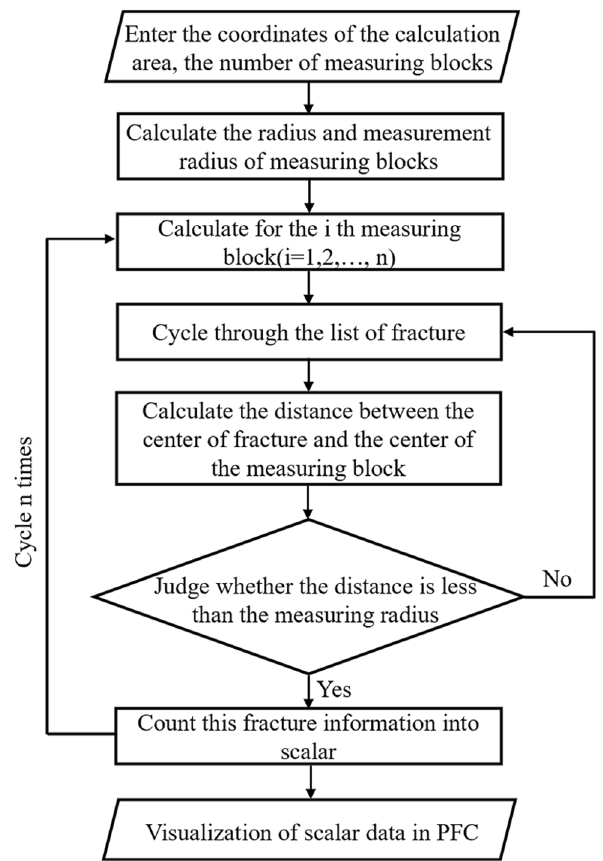
Fig. 9 Calculation flow of microcrack hotspot